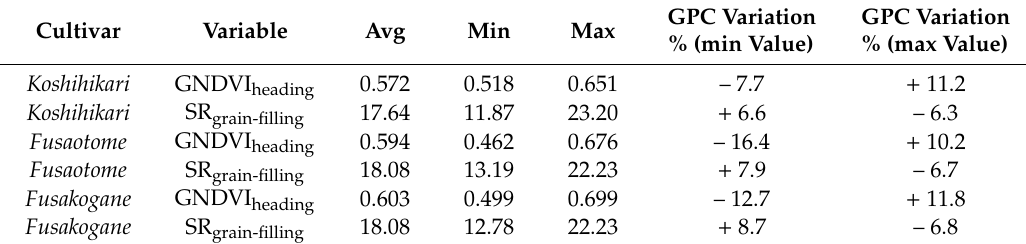
Table 4. Sensitivity analysis for multiple regression model. Avg = average value collected in the experiment from 2015 to 2017, Min = minimum value collected in the experiment from 2015 to 2017, Max = maximum value collected in the experiment from 2015 to 2017, grain protein content (GPC) variation = rate of change in the estimated GPC value compared with the average value (%), GNDVI heading = Yubaflex-based green normalized difference vegetation index at the heading stage, SR grain-filling = average daily solar radiation during the grain-filling stage (MJ/m²).